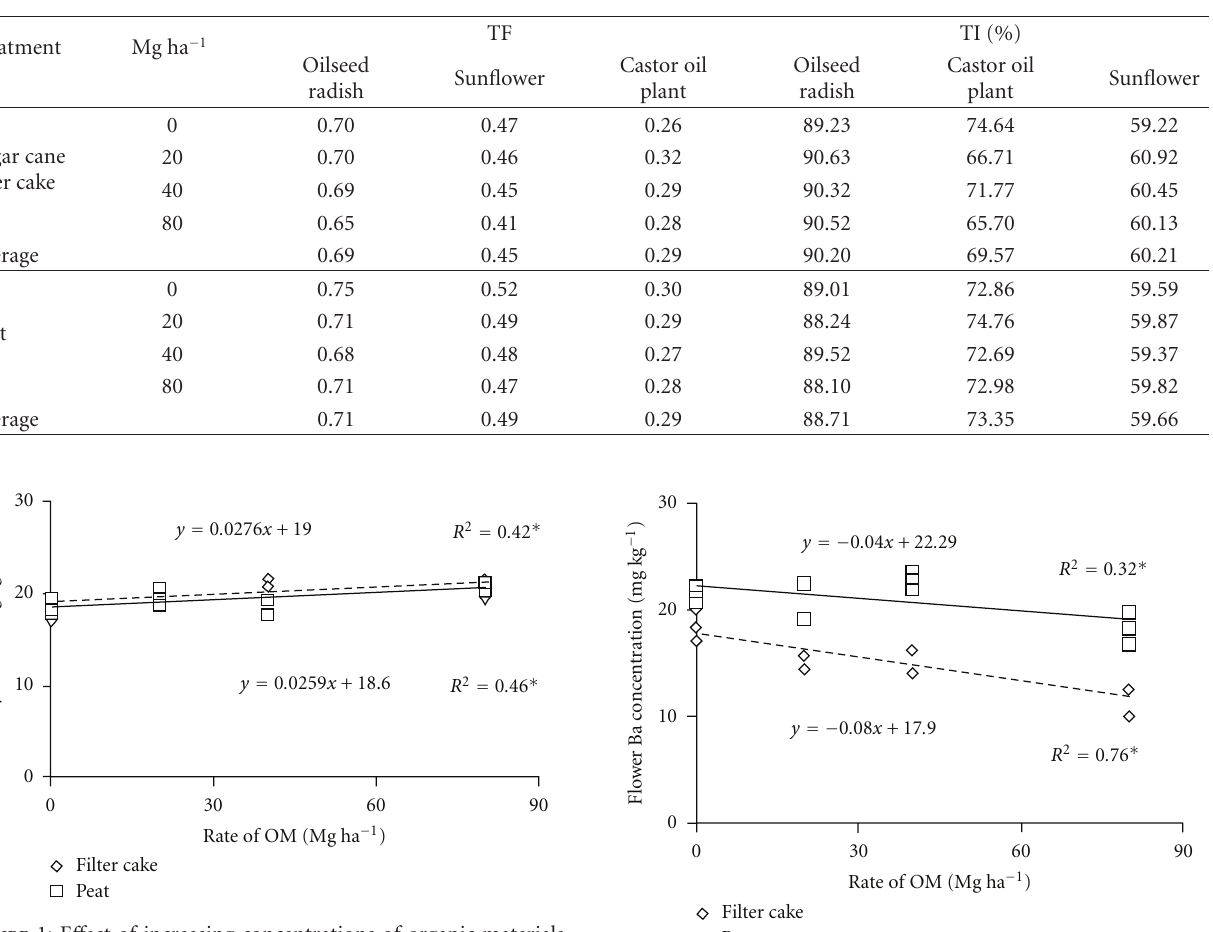
Table 6: Transfer factor (TF) and translocation index (TI) of Ba in the tested species.